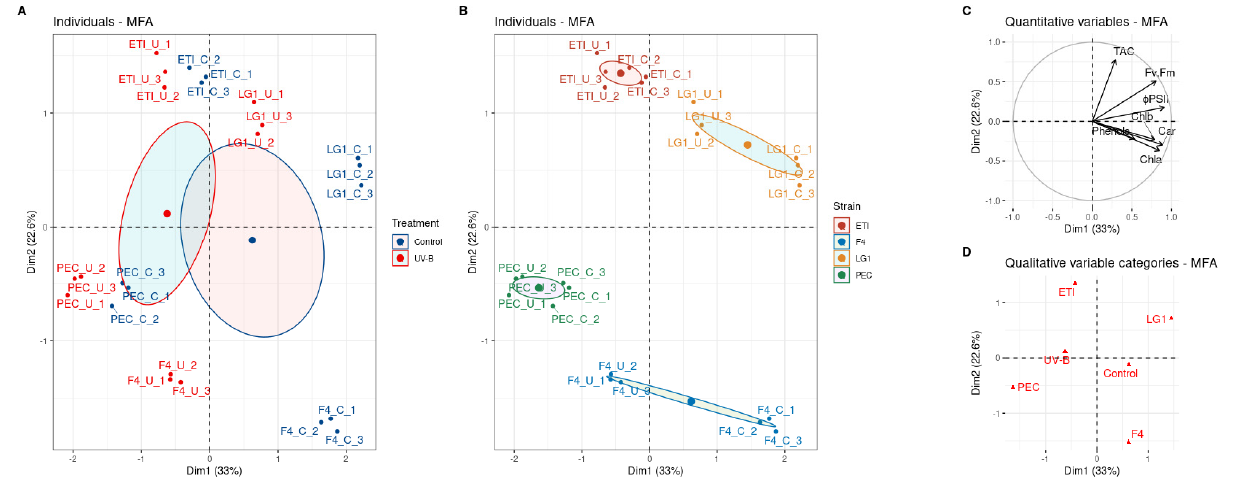
Figure 4. Multiple factor analysis (MFA) of physiological data in microalgae. ( A , B ) Score plots of the two-first principal components describing the strains and treatments. Representation of ( C ) groups of quantitative variables, and ( D ) categories of qualitative variables. Control and UV-B irradiated microalgal strains (F4, LG1, PEC and ETI) at the end of the treatment. F4 and LG1: Chlorella sorokiniana strains; PEC: Pectinodesmus pectinatus strain; ETI: Ettlia pseudoalveolaris strain; Control: non-treated microalgal strains; UV-B: microalgal strains exposed to UV-B; TAC: total antioxidant capacity; Fv.Fm: the potential efficiency of photosystem II (PSII) photochemistry represented by the ratio F v / F m ; Φ PSII: the photon yield of PSII photochemistry in the light; Chla: chlorophyll a ; Chlb: chlorophyll b ; Car: carotenoids. In this analysis, values indicated with nd (not detectable) were approximated with “0” values.